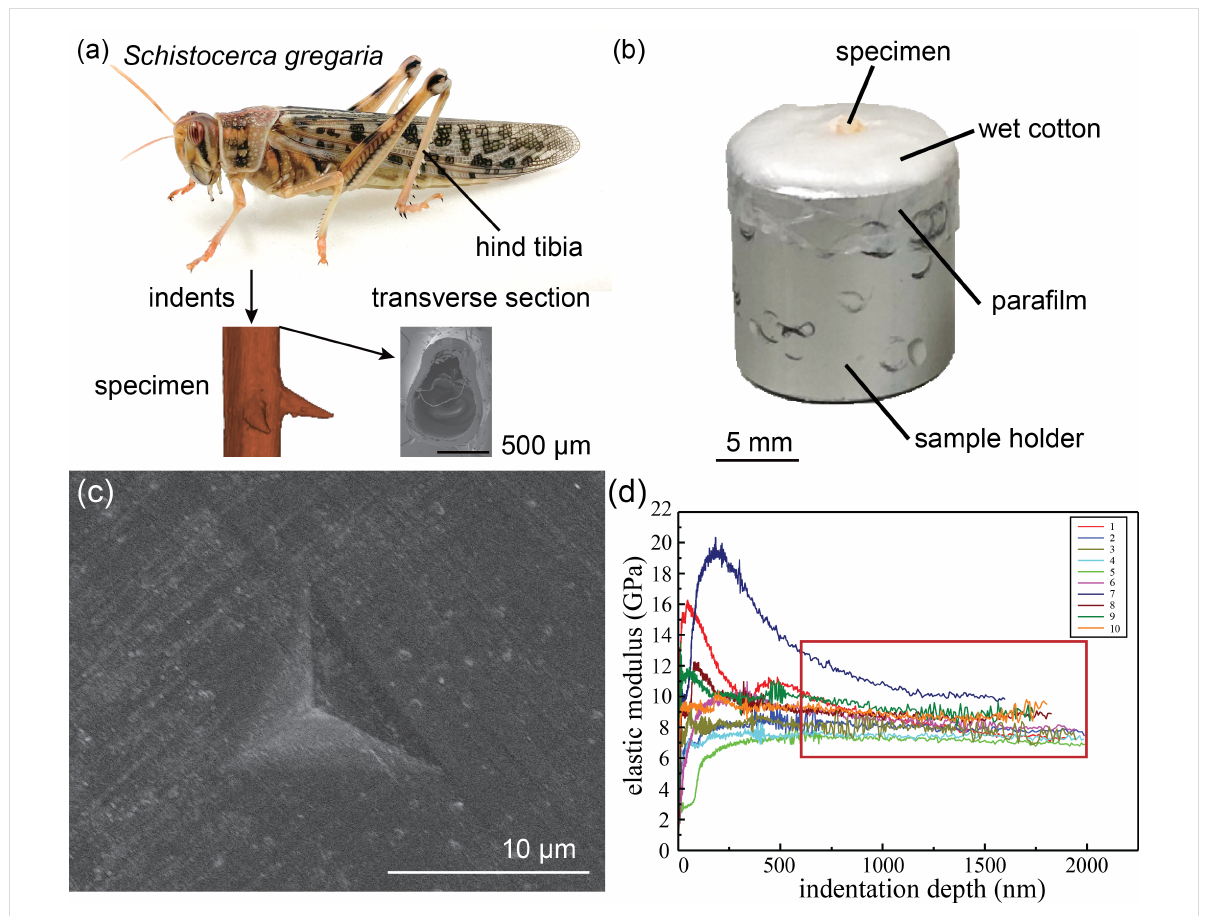
Figure 1: Specimens. (a) The middle part of the hind tibia was cut from the desert locust. Indents were performed on the transverse section of the specimen. (b) Tibial specimens were glued on the sample holder and surrounded by wet cotton. The wet cotton was covered by a layer of parafilm to minimize desiccation. (c) SEM image of an indent measured for a dry tibia. (d) Elastic modulus as a function of the indentation depth obtained from the CSM